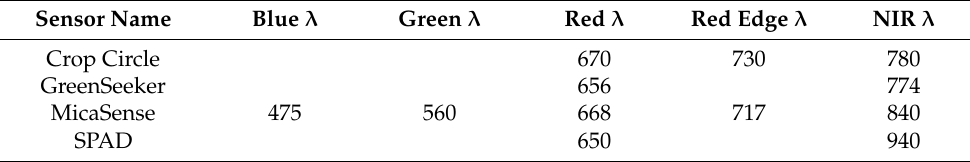
Table 3. Sensor types with their respective sensed wavelengths.